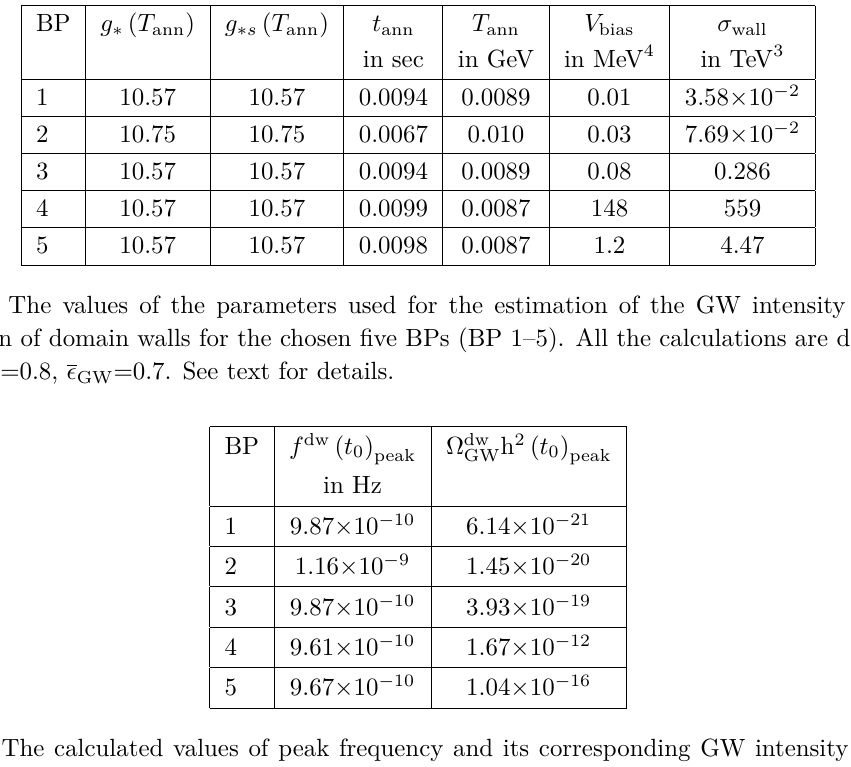
Table 3. The calculated values of peak frequency and its corresponding GW intensity from the annihilations of domain walls for the chosen five BPs (BP